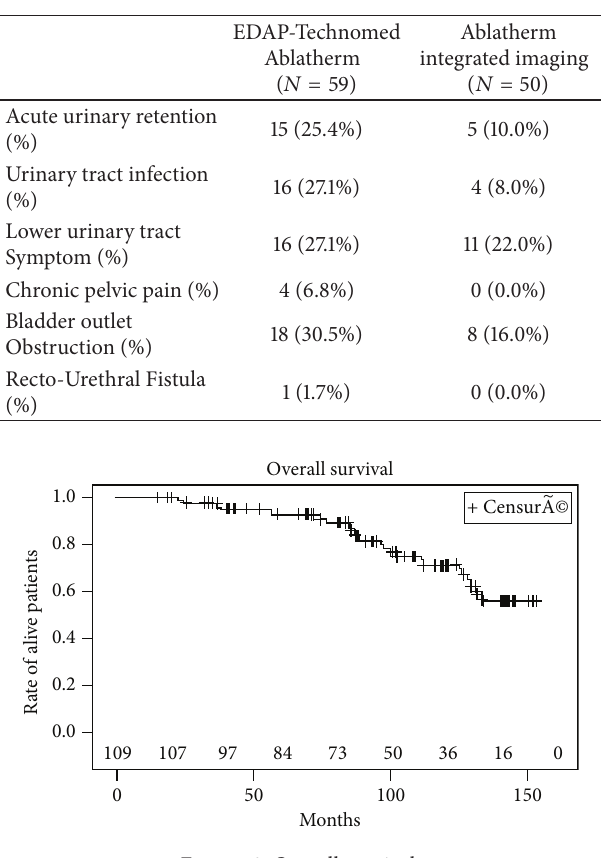
Figure 3: Overall survival.